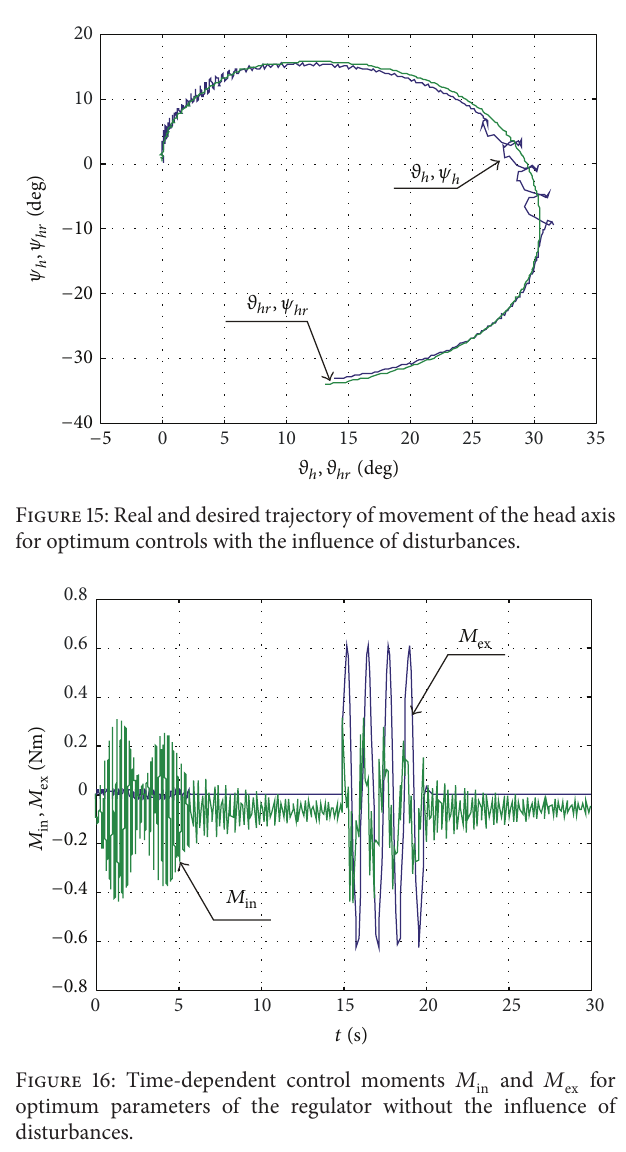
and 𝑀 for in ex